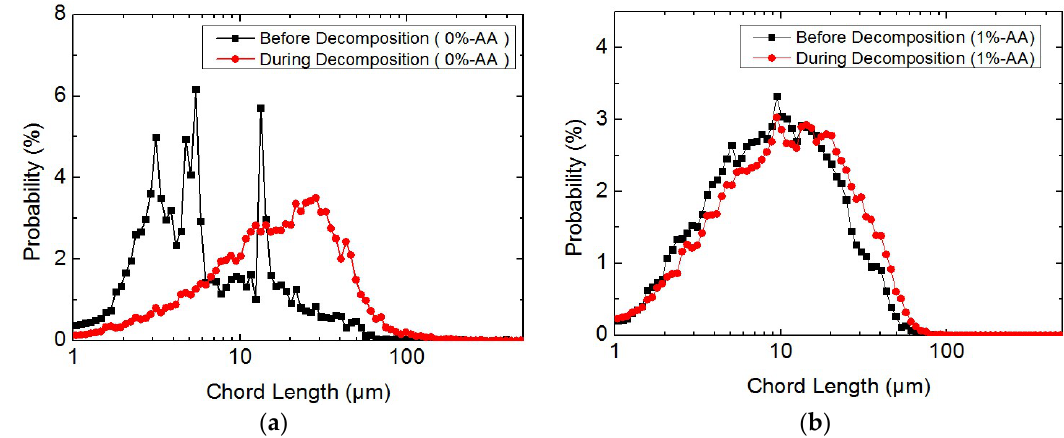
Figure 13. Influence of AA on chord length distribution during hydrate dissociation ( a , b ). ( a ) Influence of 0%-AA on chord length distribution; ( b ) Influence of 1%-AA on chord length distribution.